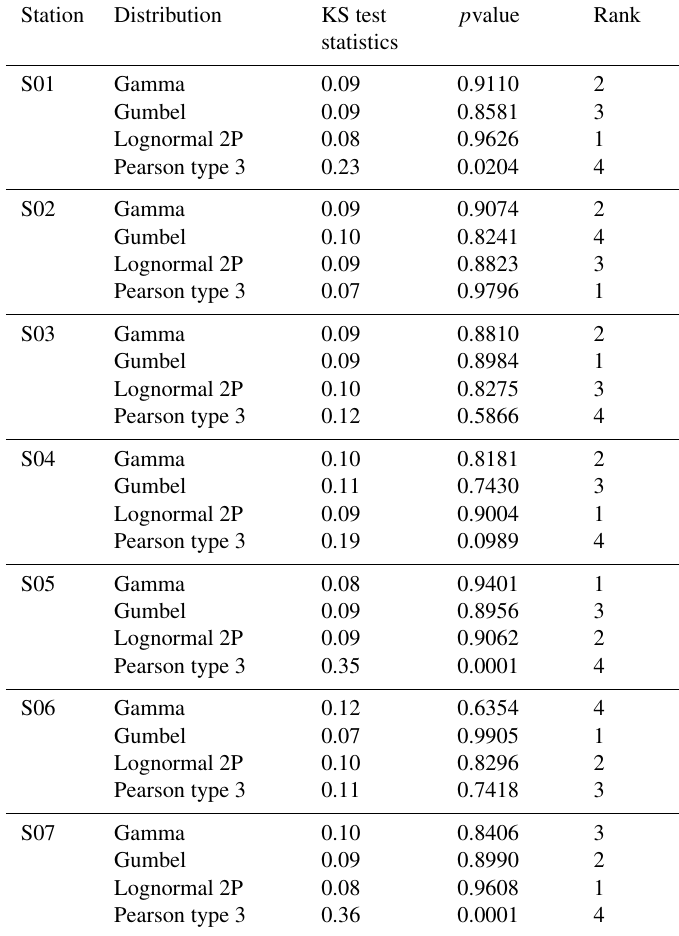
Table 6. The values of the Kolmogorov–Smirnov (KS)